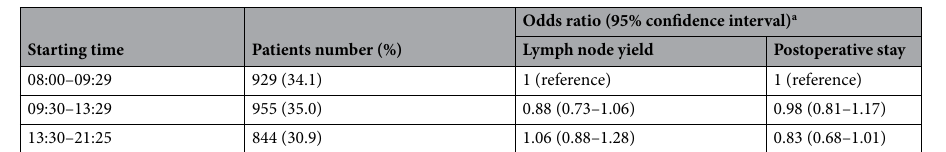
Table 4. Surgical starting time of the day for gastric cancer surgery in relation to lymph node retrieval and length of postoperative stay. a Adjusted for age, sex, health insurance coverage, neoadjuvant therapy, pathological tumor stage, surgical approach, weekday of